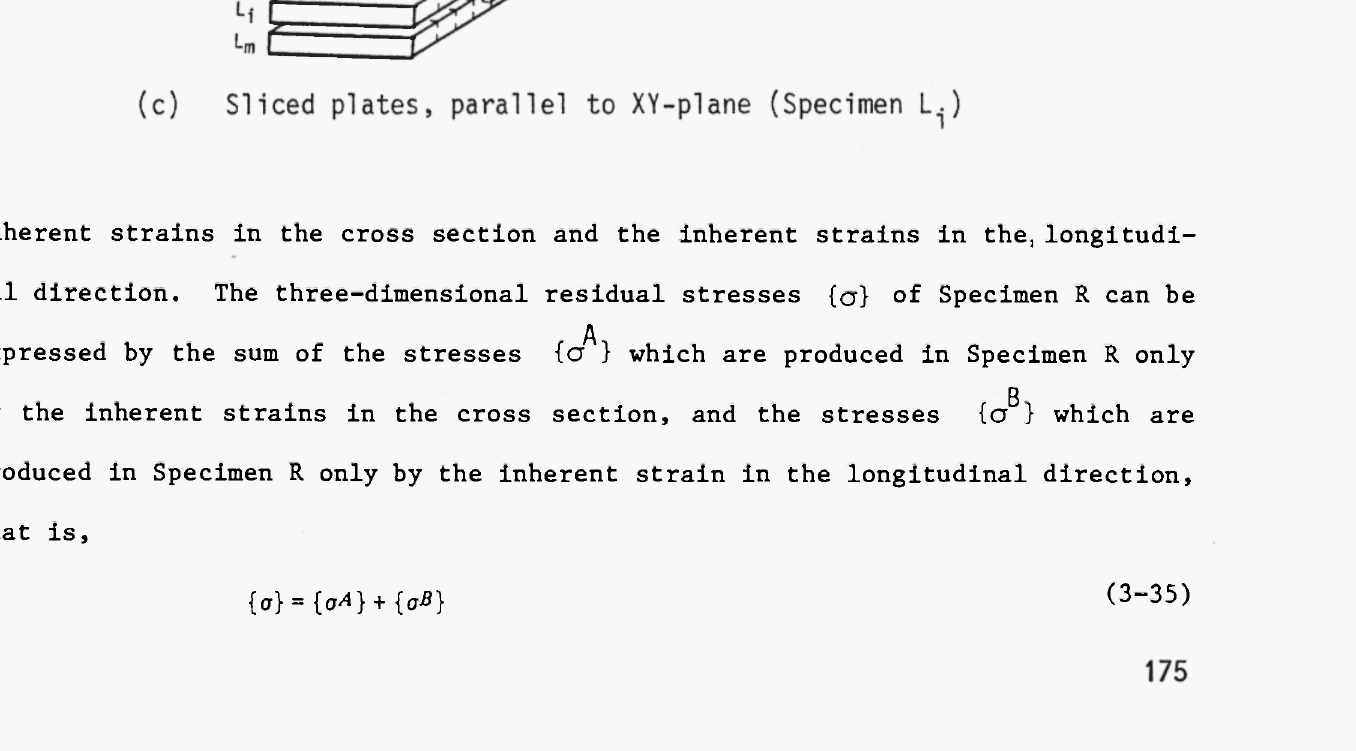
Experimental model of multi-pass welded joint (Specimen